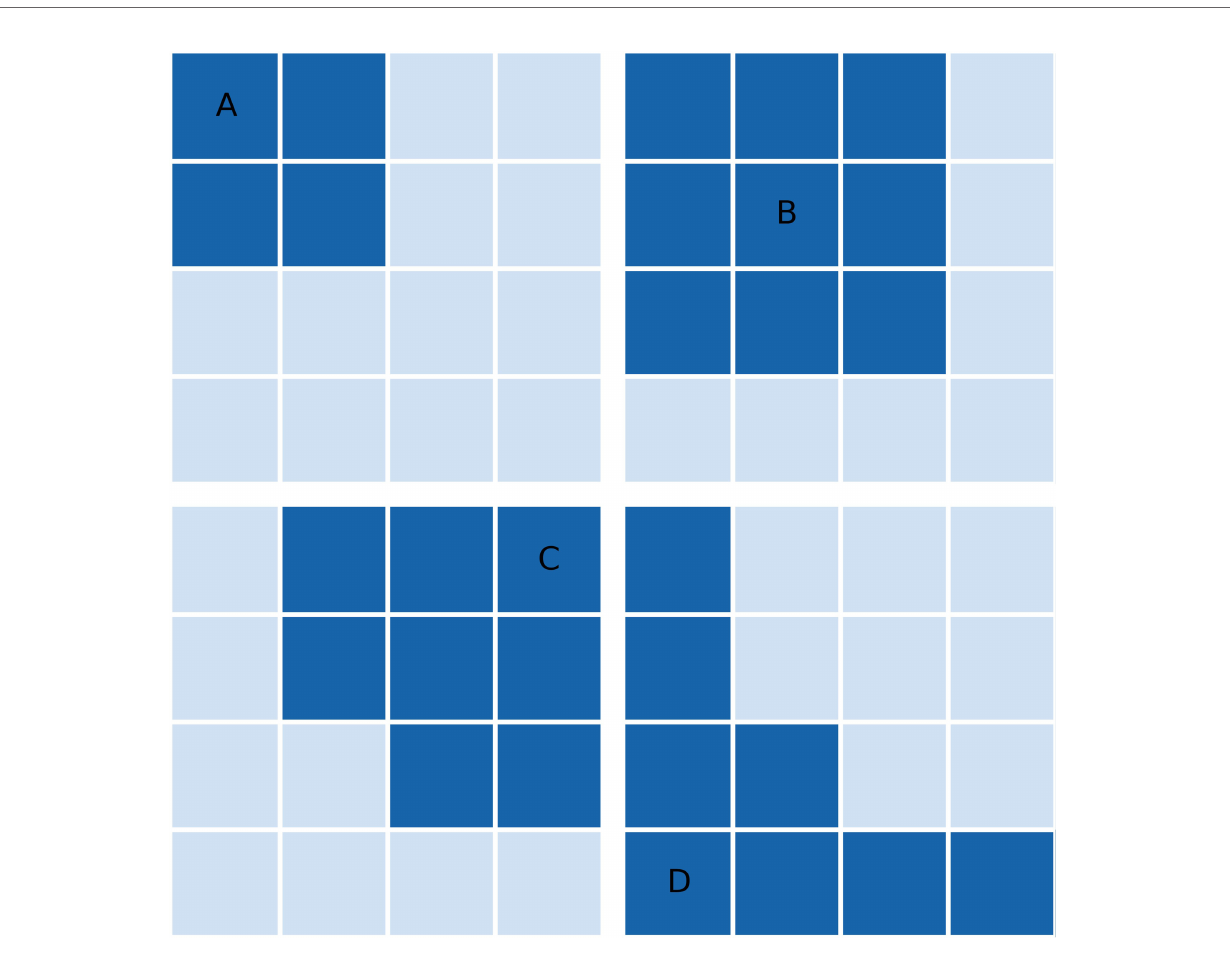
FIGURE 1 | Demonstration of the set cover optimization problem for a set of 2D grid points (universe) and 4 subsets indicated by dark grid squares. Subsets are labelled (A – D) . Of these four subsets, the greedy approximation algorithm would choose (B – D) . After the reassignment step of the Modi fi ed Greedy Set Cover algorithm, (B) would be removed from the fi nal solution as all of its points can be reassigned to (C, D)